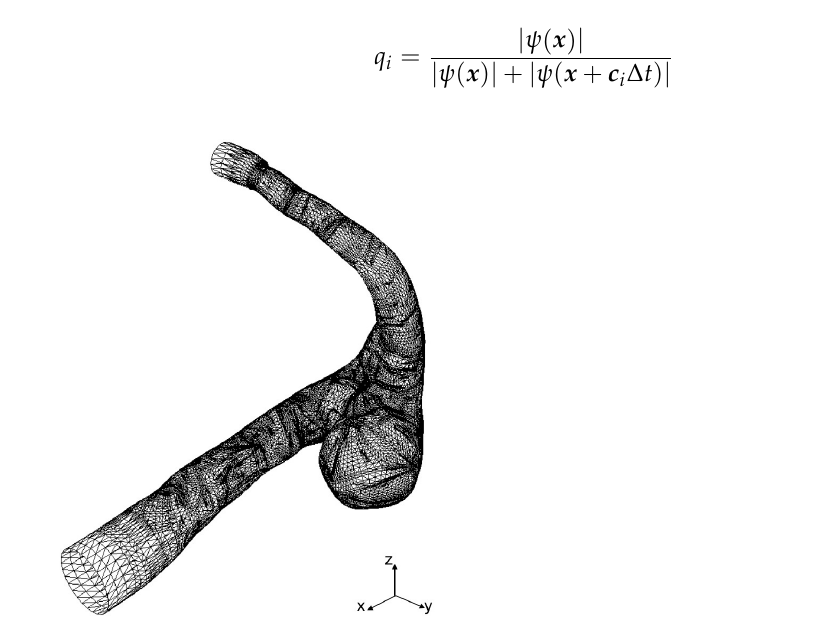
Figure 3. STL mesh of cerebral aneurysm model generated from MRA images.